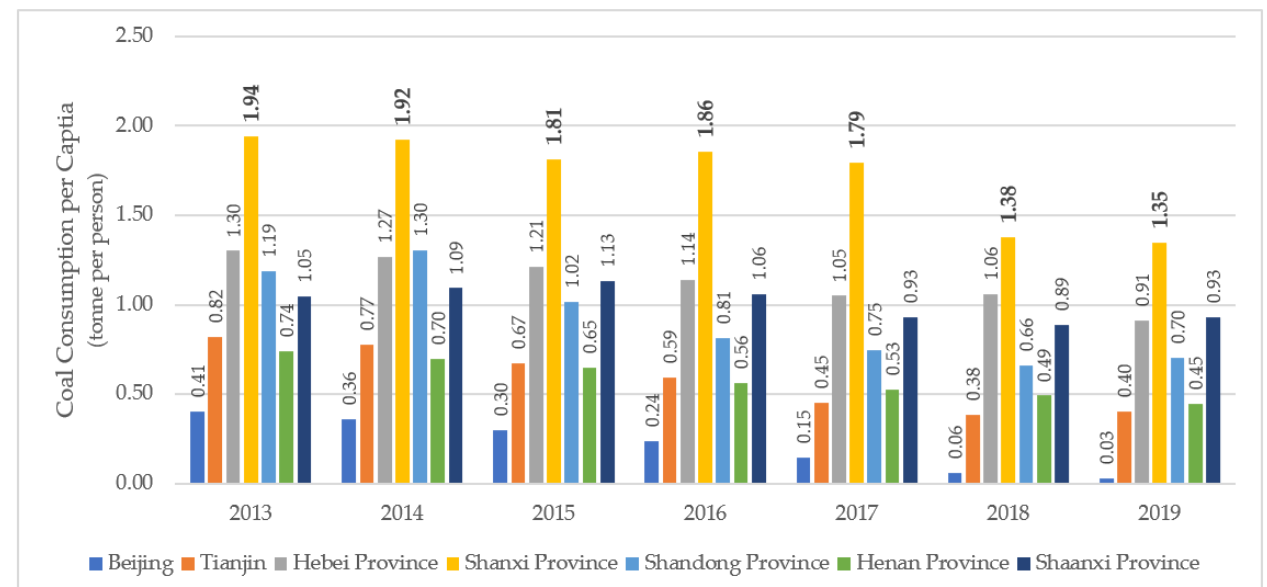
Figure 1. Coal consumption per capita in 7 municipalities and provinces. Source: China Statistical Yearbook 2014 – 2020, China Energy Statistical Yearbook 2014 – 2020.